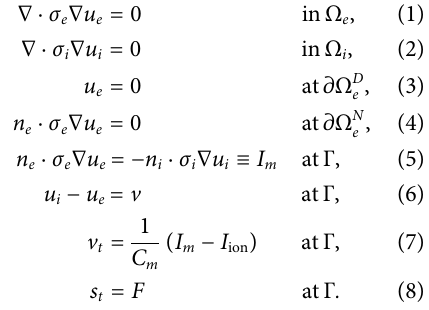
FIGURE 2 | Illustration of the EMI model domain for a collection of isolated cells. The spatial splitting approach described in Section 2.2 for a single cell may also be applied for this type of cell collection.